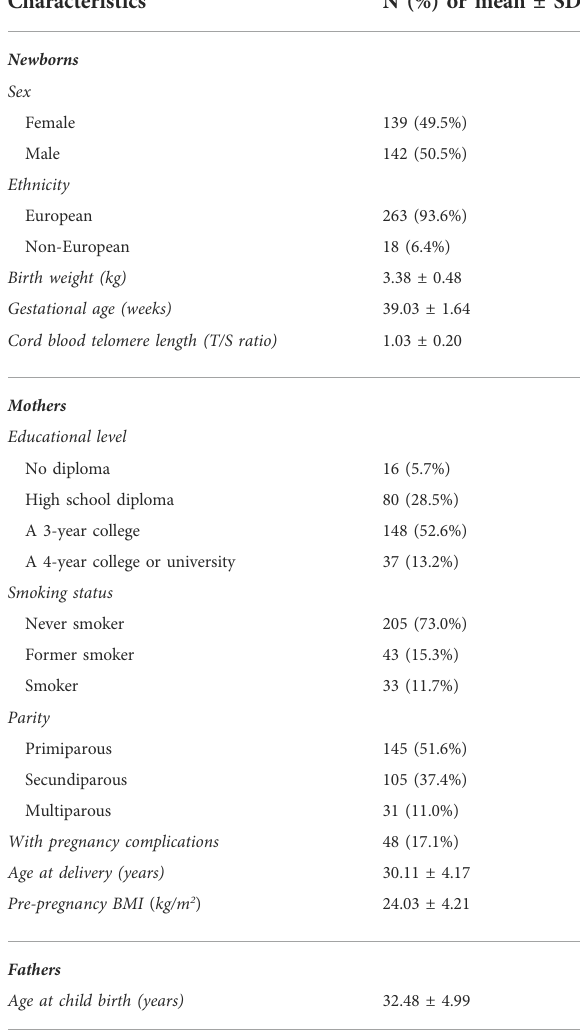
TABLE 1 Characteristics of the study population